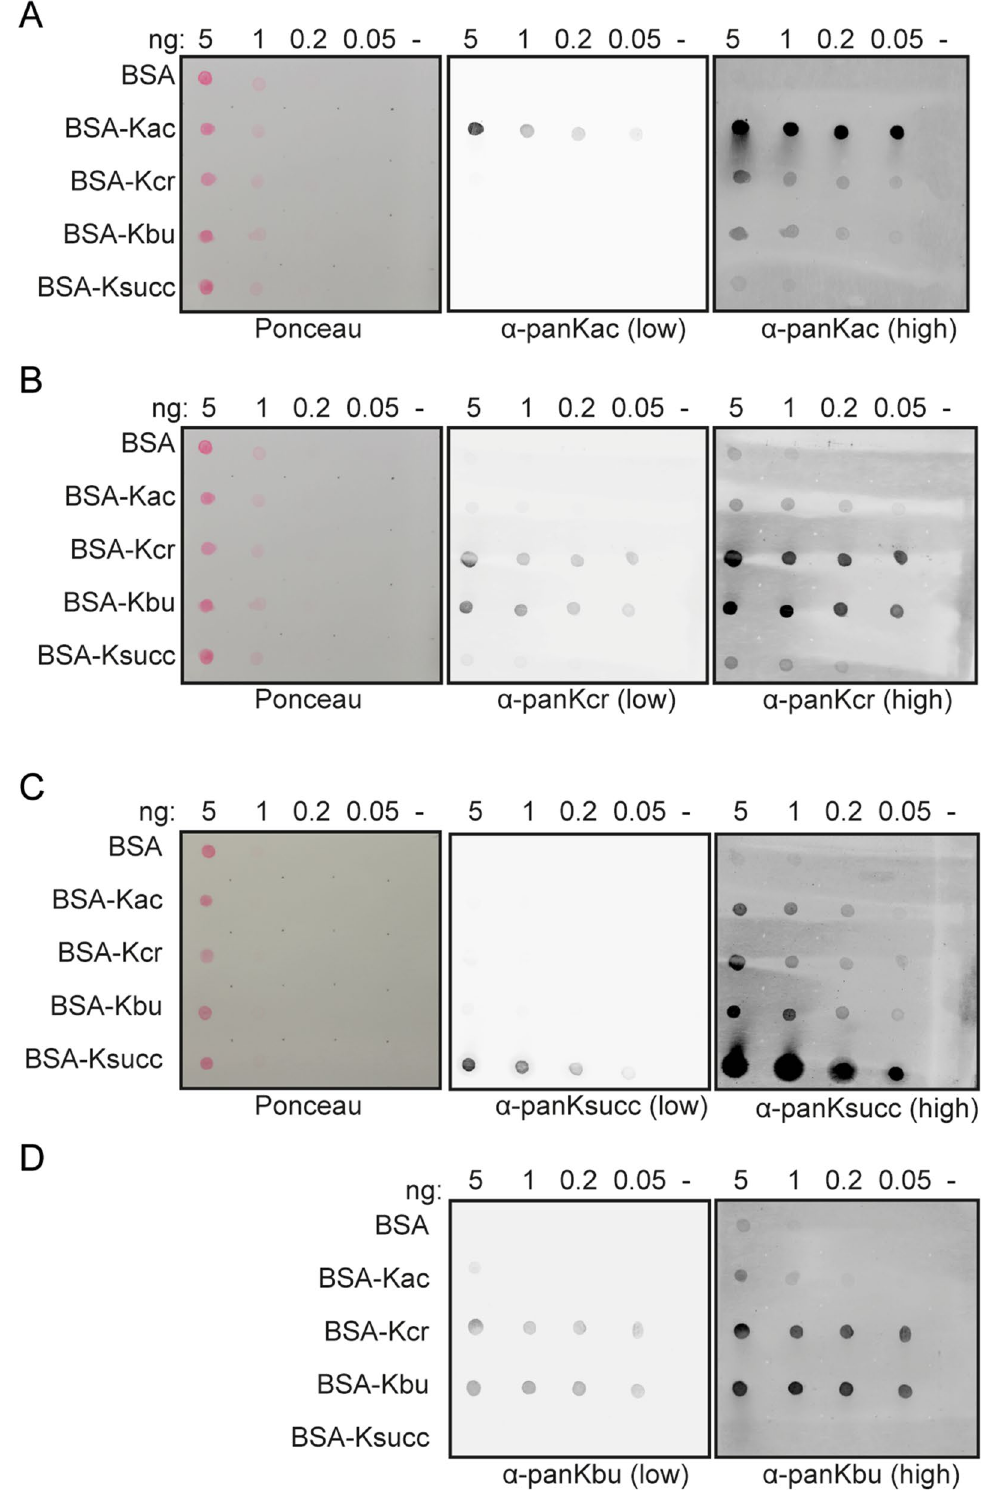
Figure 2. Dot-blots of modified BSA to test pan-K-acyl antibody specificity. ( A – D ) Immunoblot analysis of serially diluted and differently modified BSA with the indicated antibodies. Ponceau staining in ( C ) is for both succinylation and butyrylation